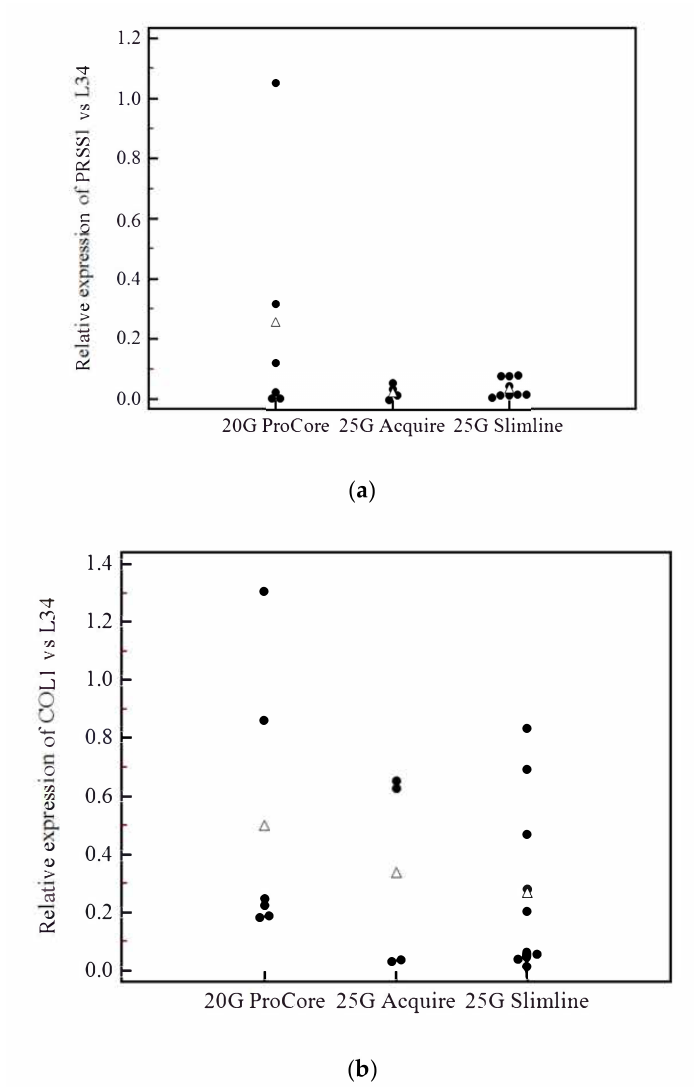
Figure 4. The 20G FNB needle resulted in a higher, despite not significant, mean contamination from acinar and stromal cells based on PRSS1 ( a ) and COL1 ( b ) gene expression. 3.5. Evaluation of Prognostic Markers is Feasible on EUS-Derived Samples and May Allow Outcome